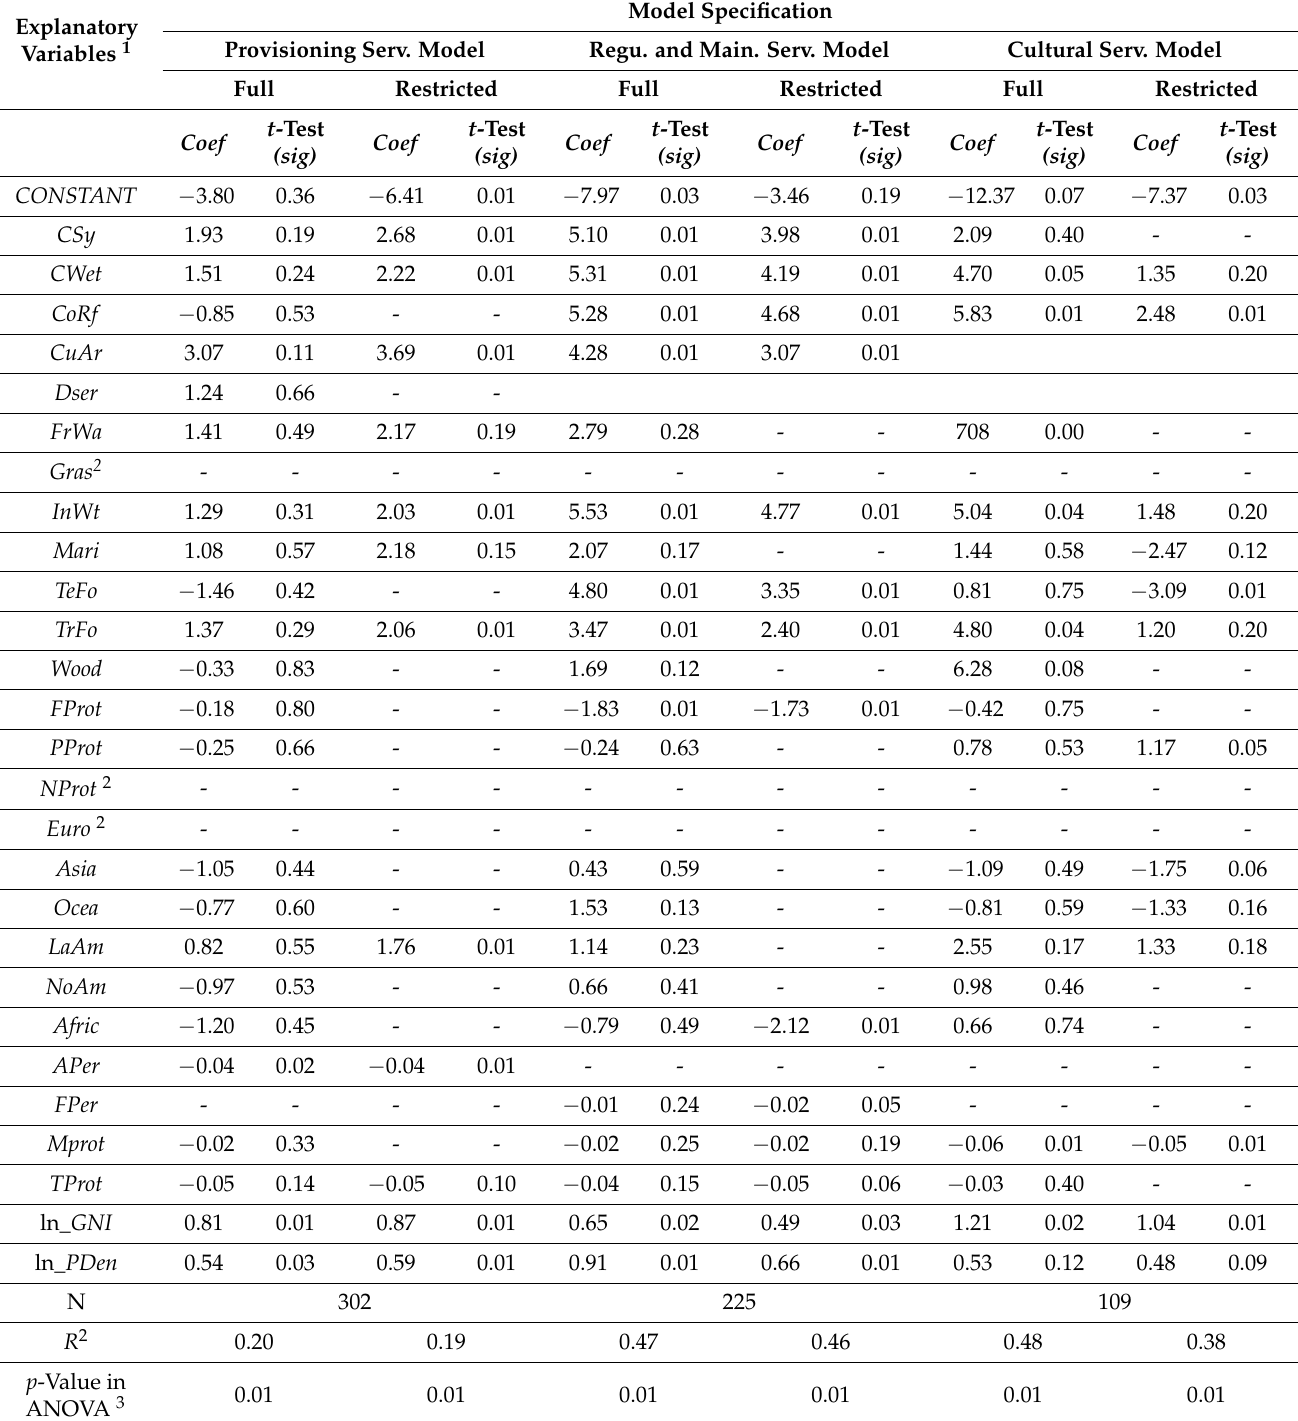
Model Specification